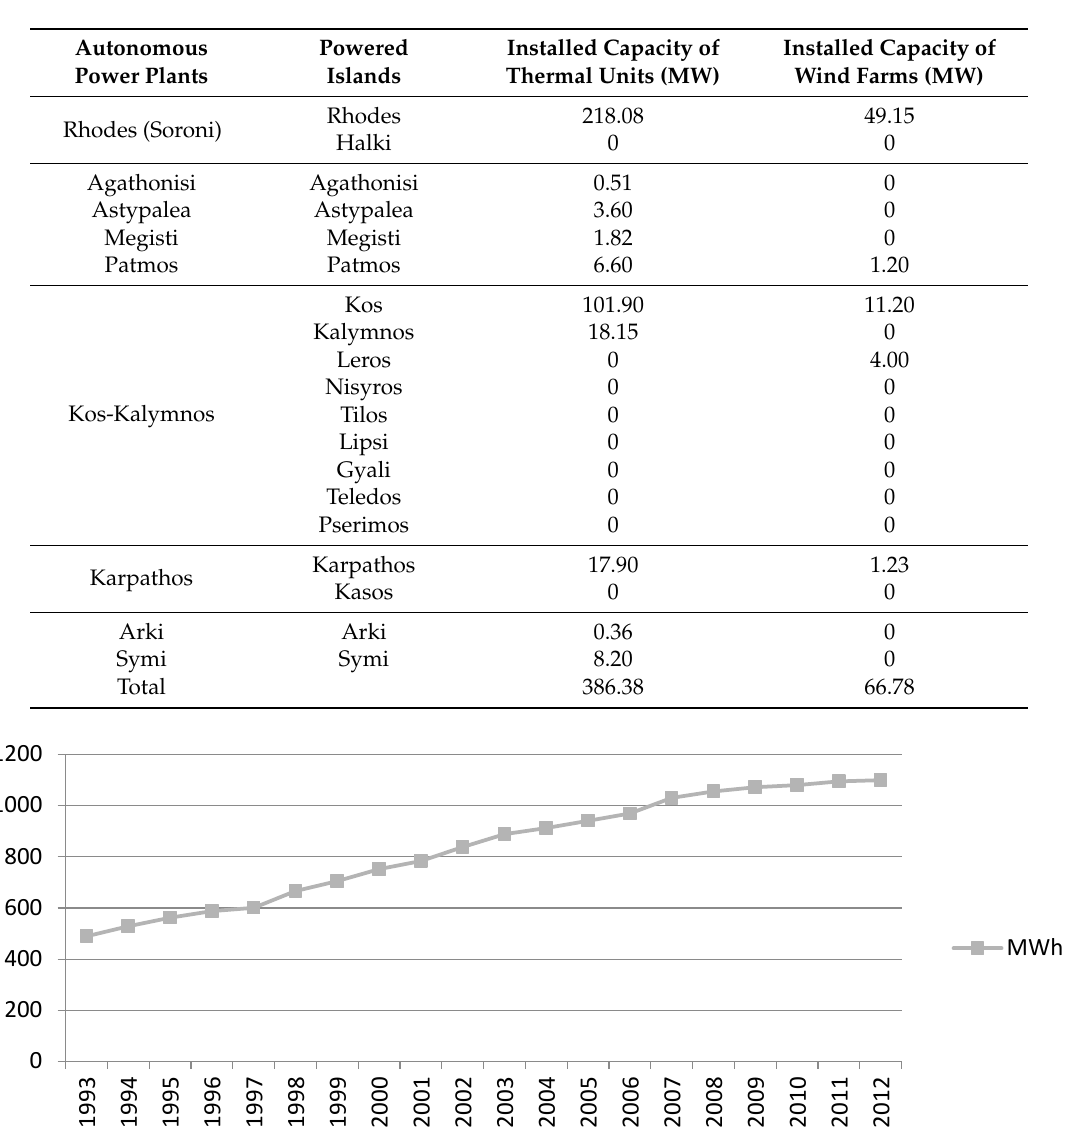
Table 1. Installed capacity of conventional units and wind farm (WF) energy production per electrical system, year 2014 [51].